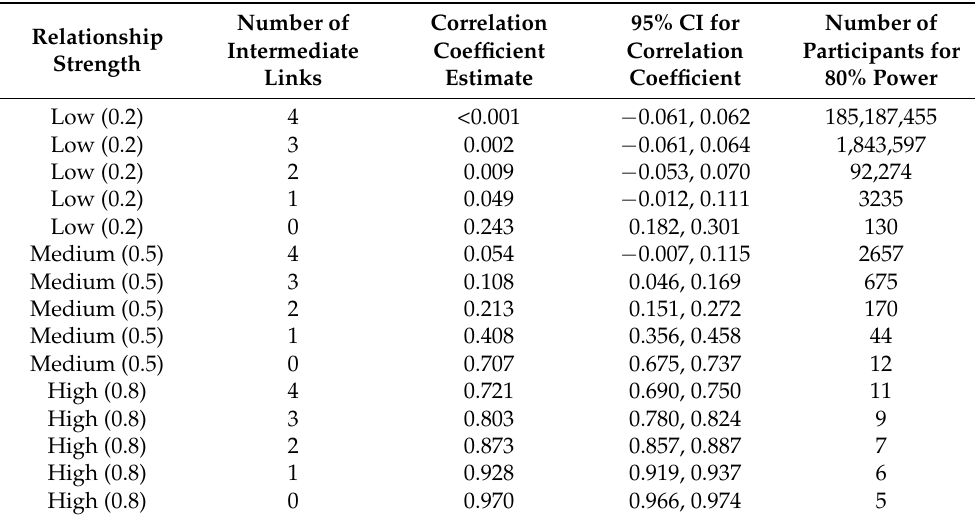
Table 1. Results of simulations, showing the estimated correlation coefficient for different scenarios of relationship strength and number of intermediates. Number of 95% CI for Correlation Number of Relationship Participants Correlation Coefficient Intermediate Strength Coefficient Estimate Links